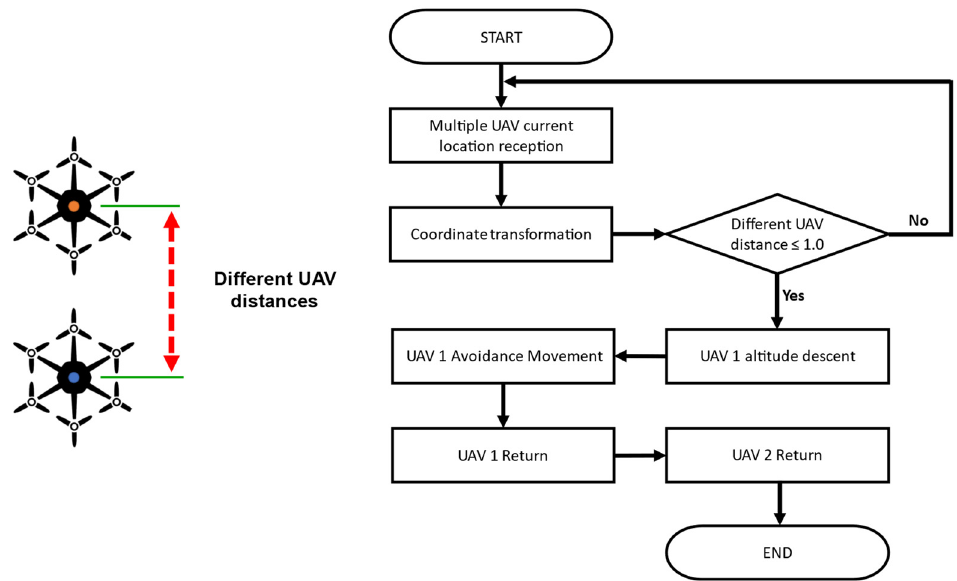
Figure 8. Flowchart of the collision avoidance algorithm in the collaborative driving of multiple UAVs.